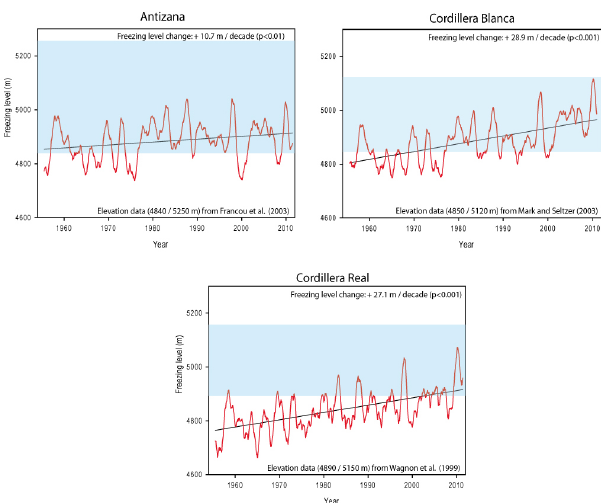
Fig. 10. Changes in freezing level height in the Andean Cordillera computed from NCEP/NCAR reanalysis data (1955–2011) for three sites (Antisana in Ecuador, Cordillera Blanca in Peru, and Cordillera Real in Bolivia) in parallel with a range of elevations from glacier snouts to the mean elevation of glaciers at each site (blue shaded area). These elevations are averages for each one of the sites corresponding to values from the 2000